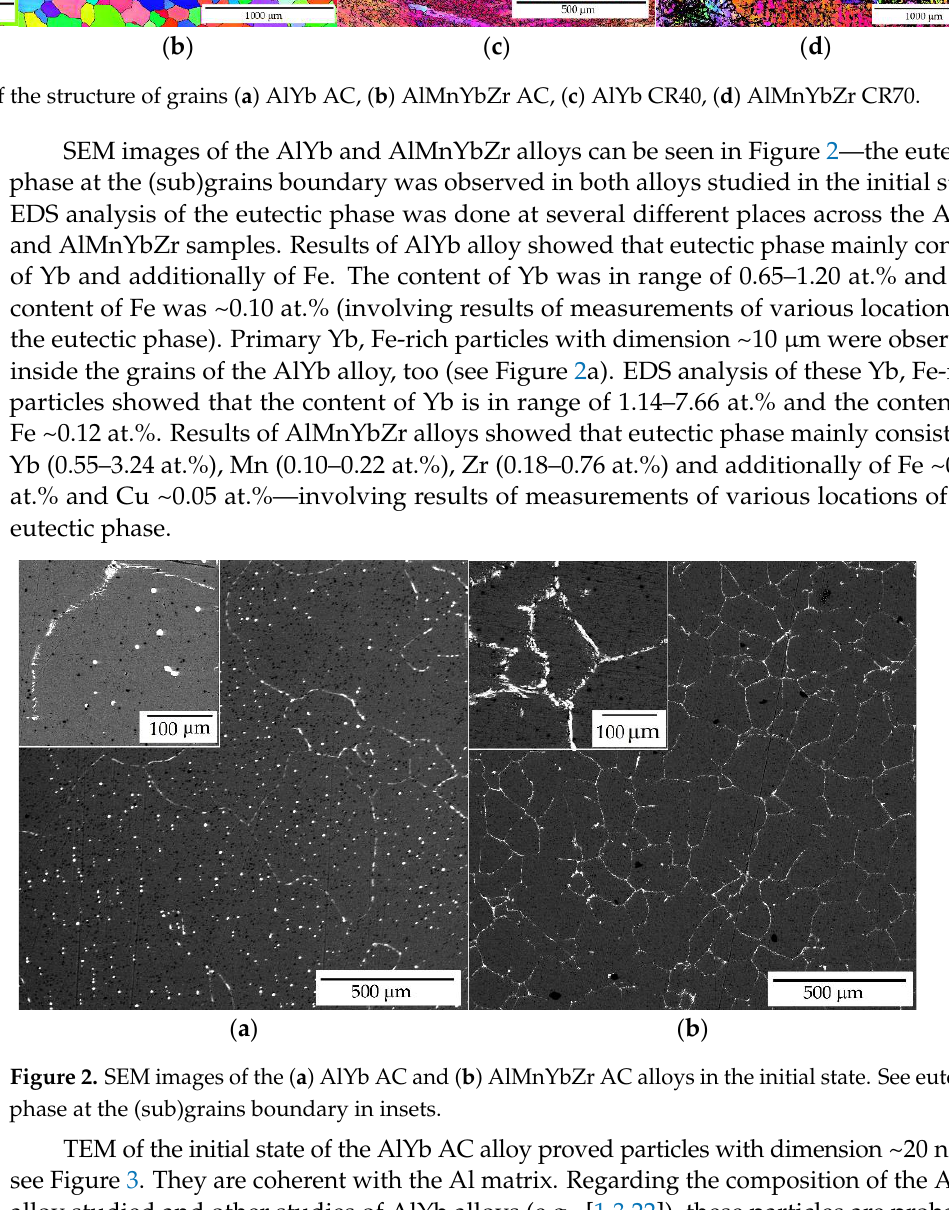
Figure 2. SEM images of the ( a ) AlYb AC and ( b ) AlMnYbZr AC alloys in the initial state. See eutectic phase at the (sub)grains boundary in insets.